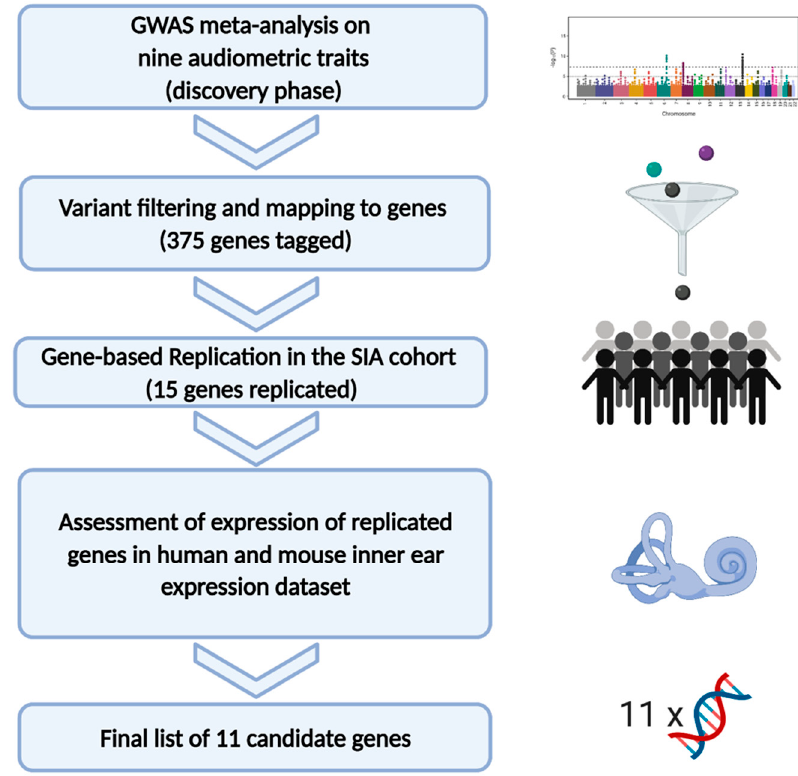
Figure 1. The picture summarizes the workflow applied in the present study. Manhattan and QQ plots of all the nine GWAS meta-analyses are shown in Figure S1. A total of 966 associations at a p -value < 1 × 10 − 5 between SNPs and audiometric traits were detected, identifying 881 unique SNPs spanning 375 different genes (Table S3). Their VEP annotation is available in Table S4.